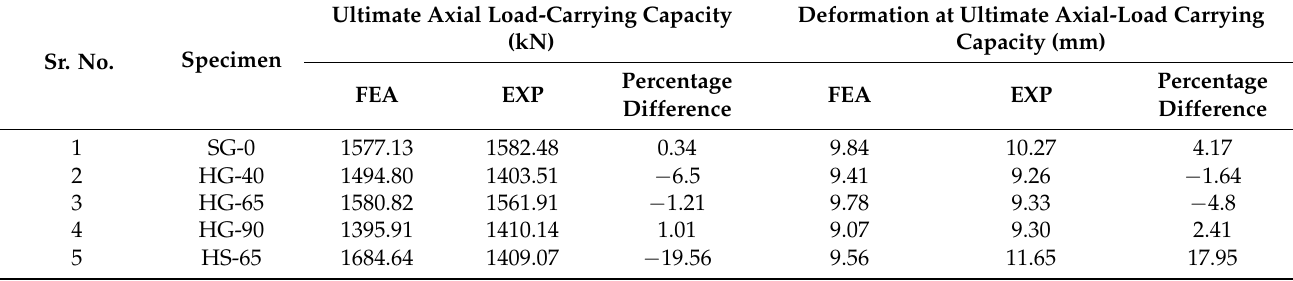
Table 4. Ultimate axial load-carrying capacities and corresponding deformations, FEA versus experiment (EXP).